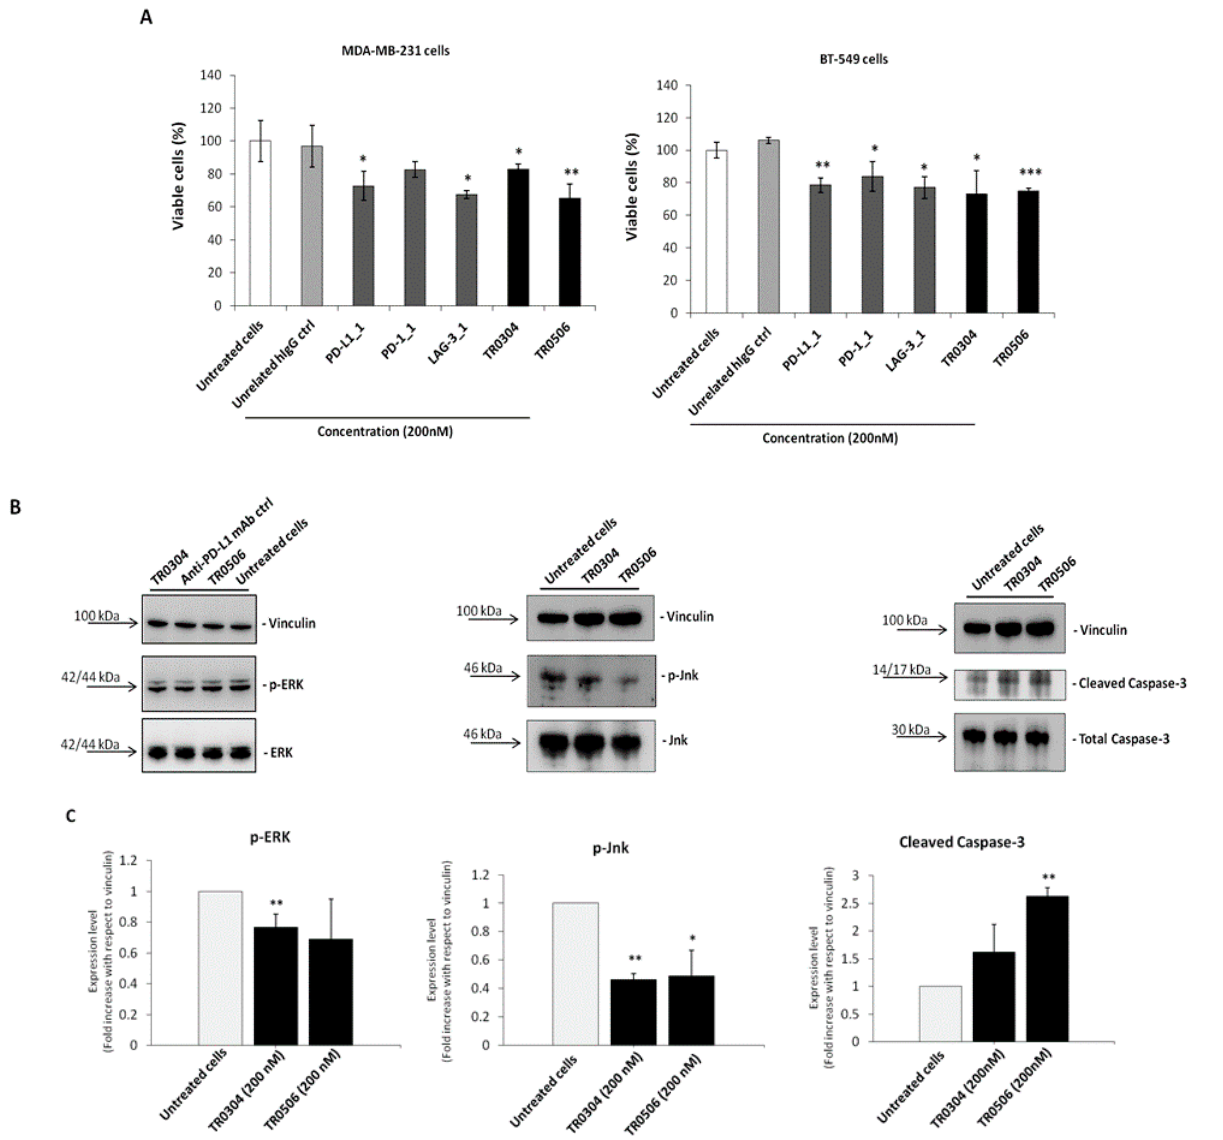
Figure 7. The novel tribodies inhibit tumor cell viability by affecting intracellular pathways. ( A ) MDA-MB-231 and BT-549 tumor cells were treated for 72 h with the tribodies TR0304, TR0506, the parental PD-L1_1, PD1.1 and LAG3.1 mAbs or a human unrelated IgG at the concentration of 200 nM. Cells were counted by using the Trypan Blue exclusion test and cell survival is expressed as percentage of viable cells with respect to the untreated cells. ( B ) Western blotting analyses of ex-tracts from MDA-MB-231 breast tumor cells, treated for 72 h as indicated, by using the anti-Erk or -phospho- Erk, the anti-Jnk or -phospho-Jnk, the anti-Caspase-3 or anti-Cleaved Caspase3 an-tibodies and the anti-vinculin Ab, used to normalize. ( C ) Densitometry quantification of signals from Western blotting analyses. The protein levels of phospho-Erk, phospho-Jnk or Cleaved Caspase-3 are expressed as fold increase with respect to cells untreated and the intensity of the bands was normalized to vinculin. The values were reported as the mean of at least three determinations obtained in three independent experiments. Error bars depicted means ± SD. p -value: *** p ≤ 0.001; ** p < 0.01; * p <